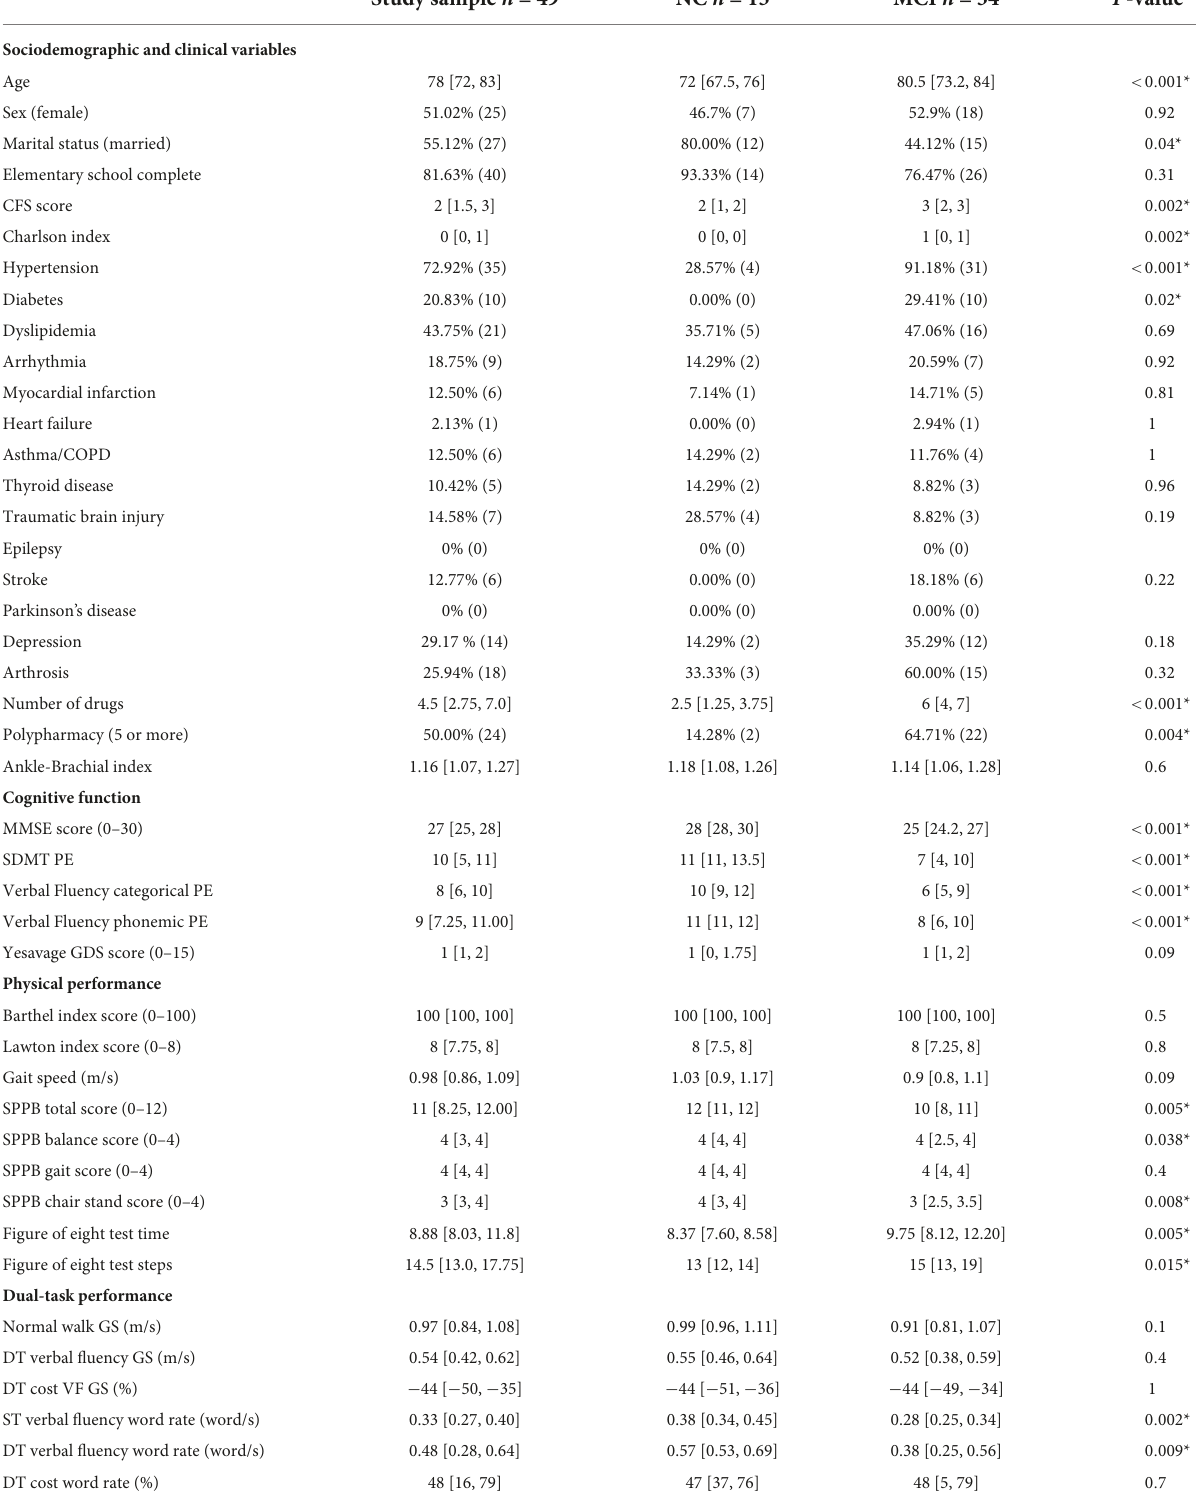
TABLE 1 Descriptive of global sample and between-group comparison.